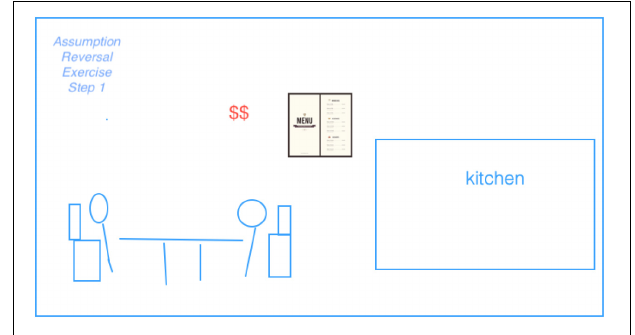
FIGURE 1 | Some assumptions underlying the mainstream restaurant business